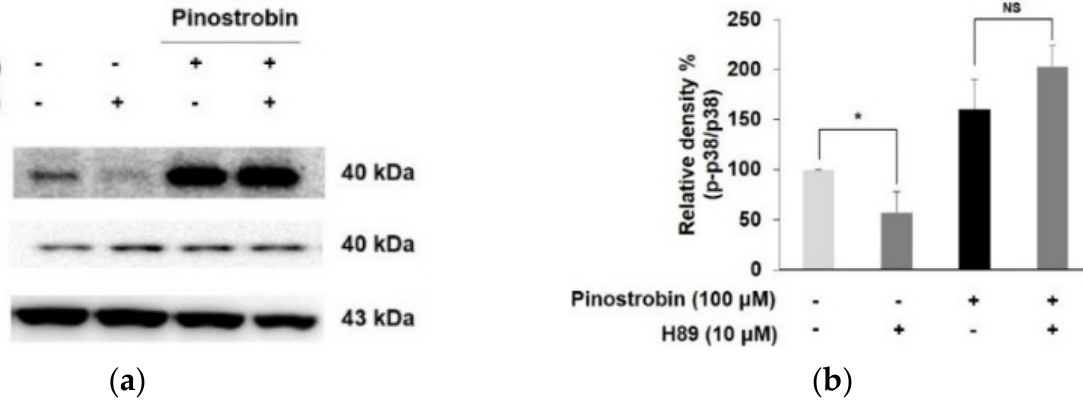
Figure 7. Effect of pinostrobin with H89 on phosphorylated p38 expression in B16F10 cells. ( a ) Cells